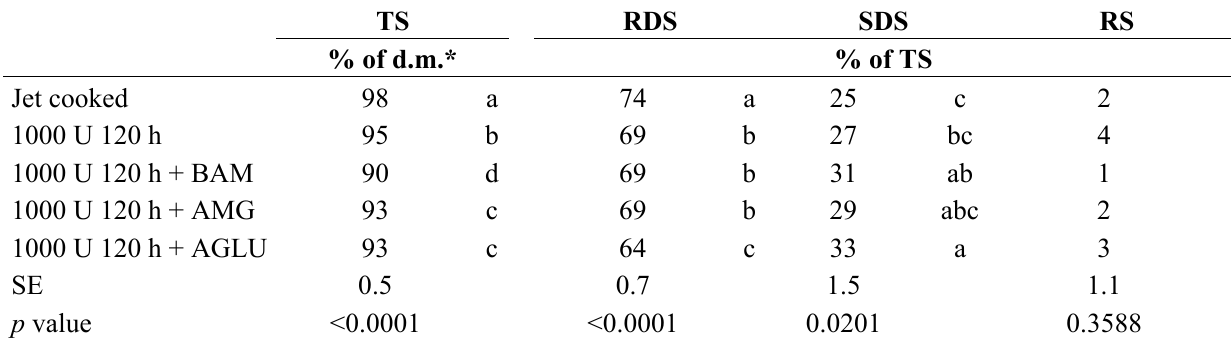
Table 4. The effect of application of the additional branching enzymes on waxy maize. TS RDS SDS RS % of d.m.* % of